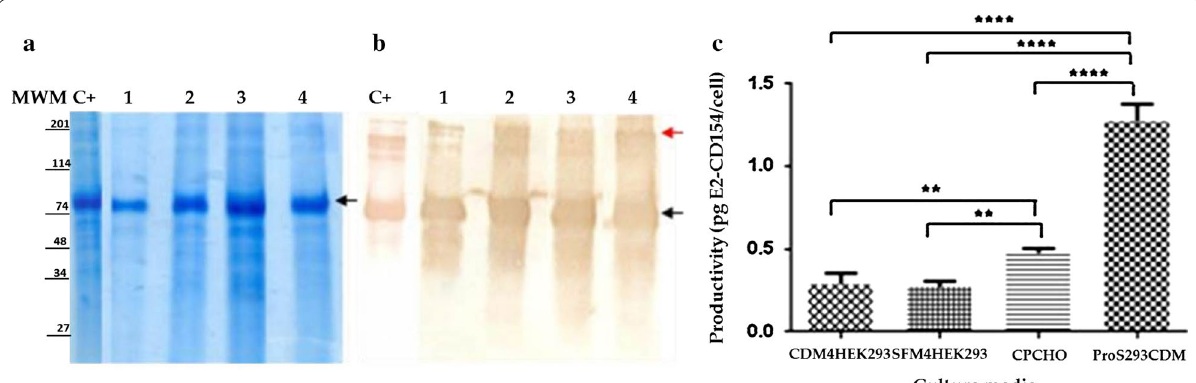
Fig. 2 Analysis of the E2‑CD154 proteins produced in the culture supernatants of HEK‑293‑E2‑CD154 cells growing in the four different commercial media a SDS‑PAGE 10% under reducing conditions, b Western blotting using MAb2.3HRP monoclonal antibody 1:5000. MWM: Molecular weight marker; C : Positive control of E2‑CD154 (Suárez et al. 2017); 1: Pro293SCDM medium; 2: CDM4HEK293 medium; 3: SFM4HEK293 medium; 4: CPCHO + medium. In all cases, 10 µL of each culture supernatant from HEK‑293‑E2‑CD154 cells were applied. c Productivity of HEK‑293‑E2‑CD154 cells in terms of E2‑CD154 protein pg per cell, which was calculated from four replicates in all cases. Error bars indicate the standard deviations. Asterisks mean statistical significance (**p < 0.005) and ***p < 0.0001)